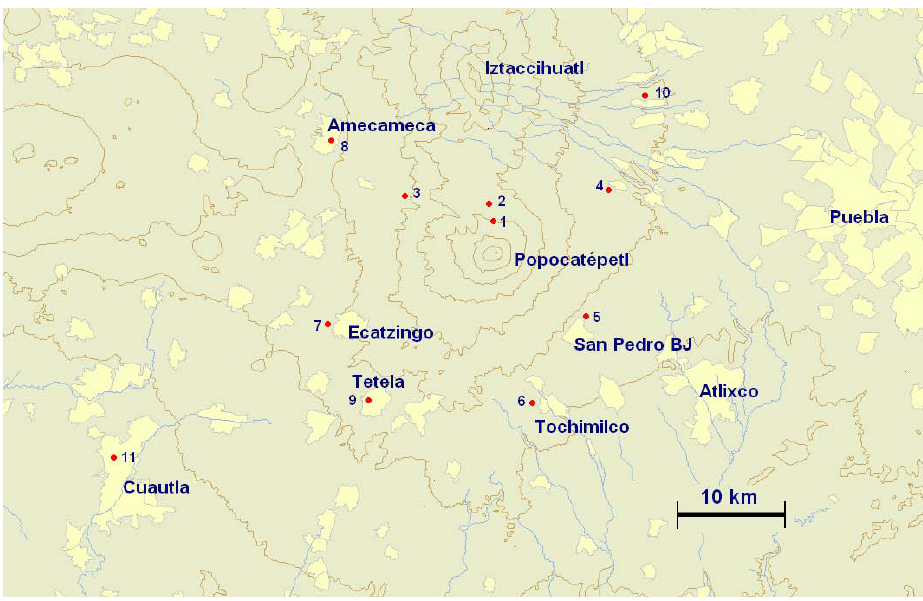
Fig. 2. Location of ash-sampling sites: 1 (4100ma.s.l., on the volcano slope); 2 (Tlamacas); 3 (km 13 Tlamacas-Amecameca road); 4 (Santiago Xalizintla); 5 (San Pedro BJ); 6 (Tochimilco); 7 (Ecatzingo); 8 (Amecameca); 9 (Tetela del Volc´an); 10 (Atexcac); 11 (Cuautla).